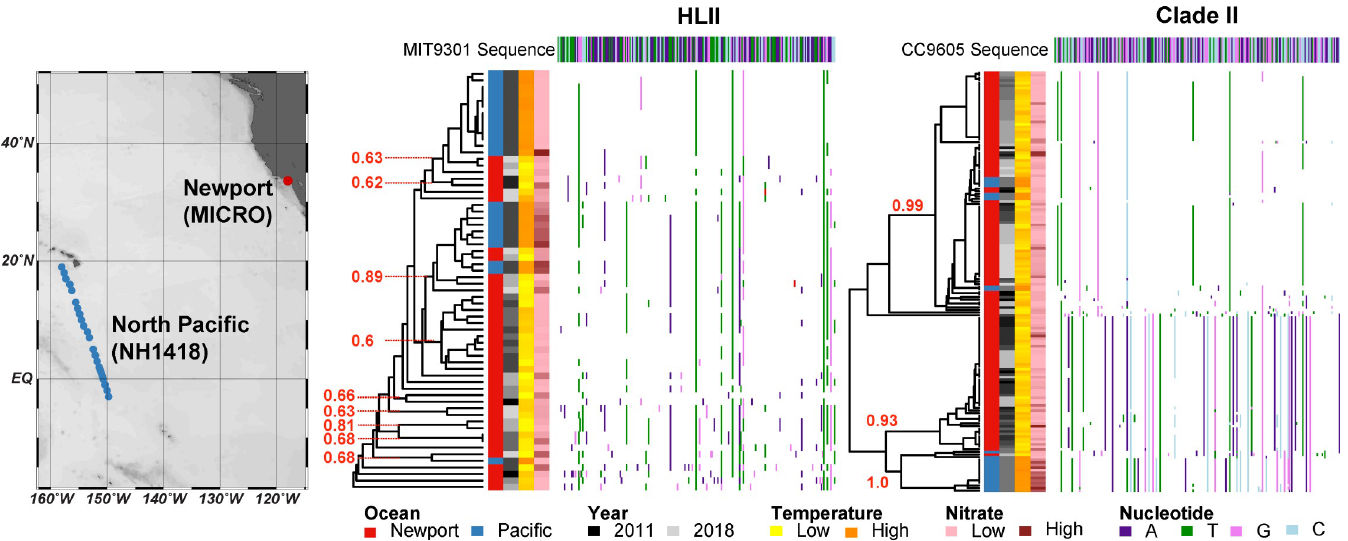
Fig 5. Comparison of Prochlorococcus HLII and Synechococcus Clade II rpo C1 highly conserved SNPs detected at the Newport MICRO times series and on Pacific Ocean cruise NH1418 (September-October 2014; 19.00˚N, -158.00˚W to -3.00˚N, -149.67˚W; 5m depth). Newport and NH1418 samples largely clustered separately but had some overlap in SNPs. Samples with less than 10 sequences were removed from the analysis. Clade labels (red) indicate bootstrapped Jaccard similarity values for the most stable clusters with more than two samples (values < 0.5 are unstable, 0.6–0.75 weak stability, 0.75–0.85 stable, and > 0.85 highly stable).